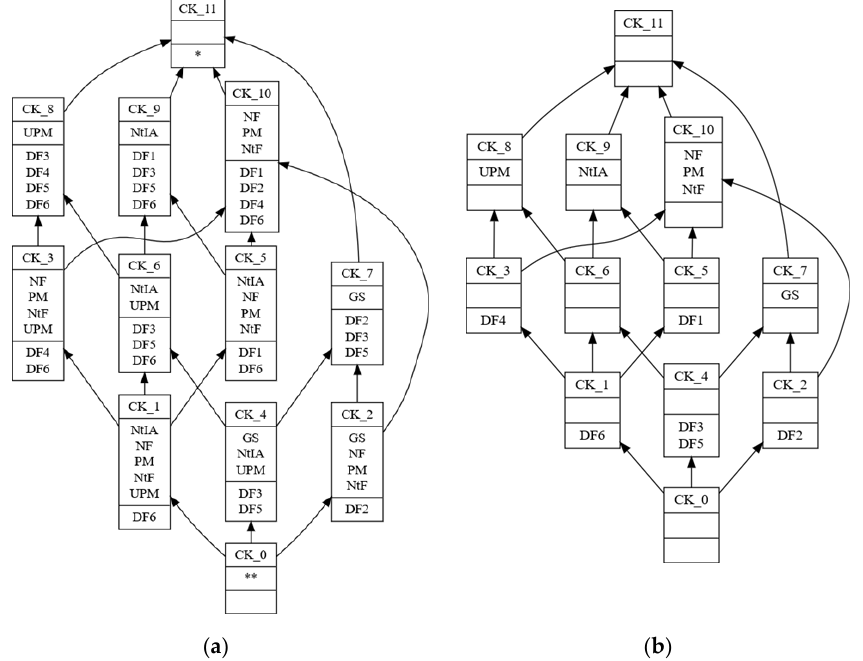
Figure 2. ( a ) The concept lattice 𝐿 𝐾 built from the formal context 𝐾 (Figure 1); * is the set of all objects 𝐺 ; ** is the set of all attributes 𝑀 ; ( b ) the simplified version of 𝐿 𝐾